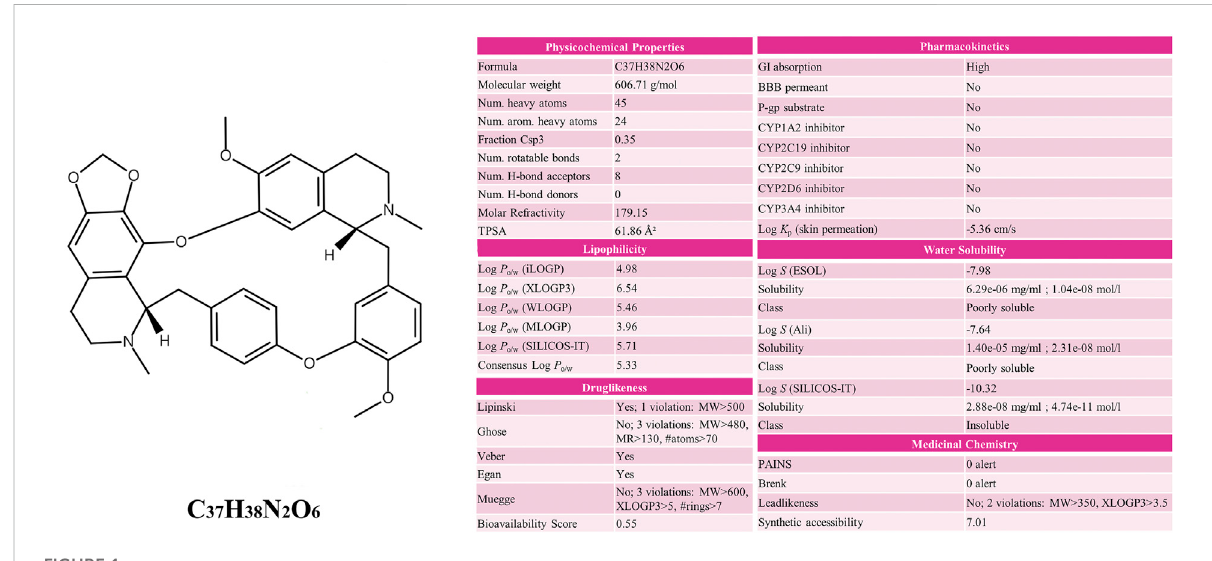
FIGURE 1 Chemical structure and ADME parameters of